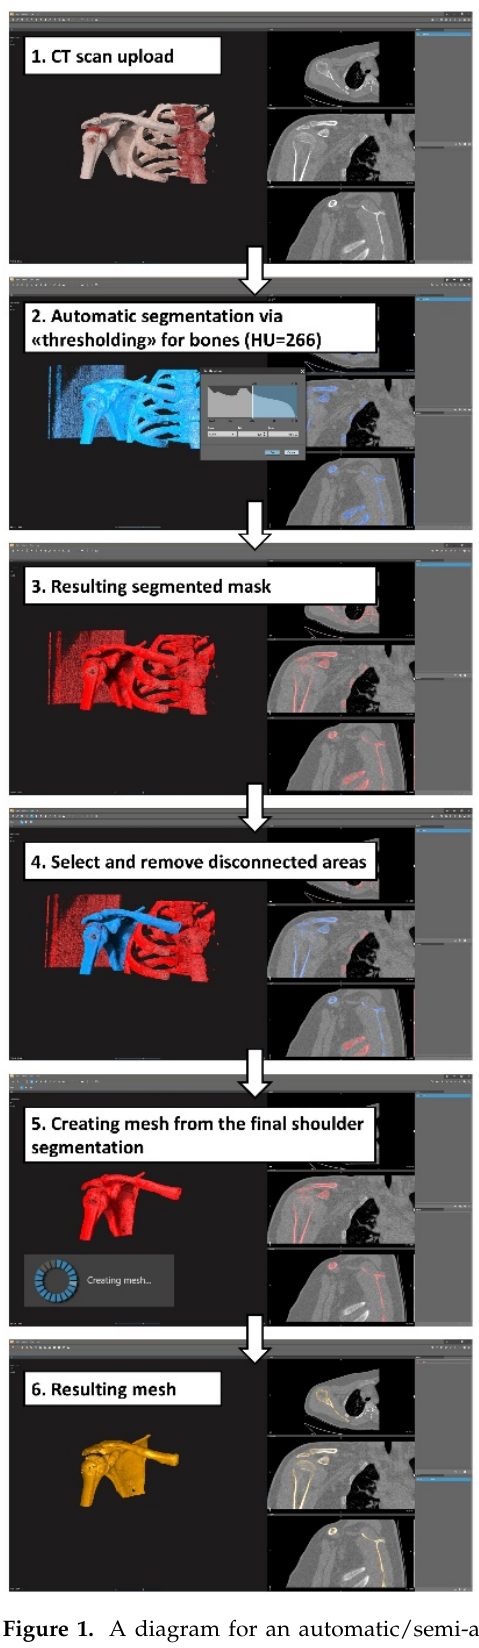
Figure 1. A diagram for an automatic/semi-automatic workflow for the segmentation process: present exemplary screenshots obtained during this process using D2P software; a very similar workflow was followed for the other four software